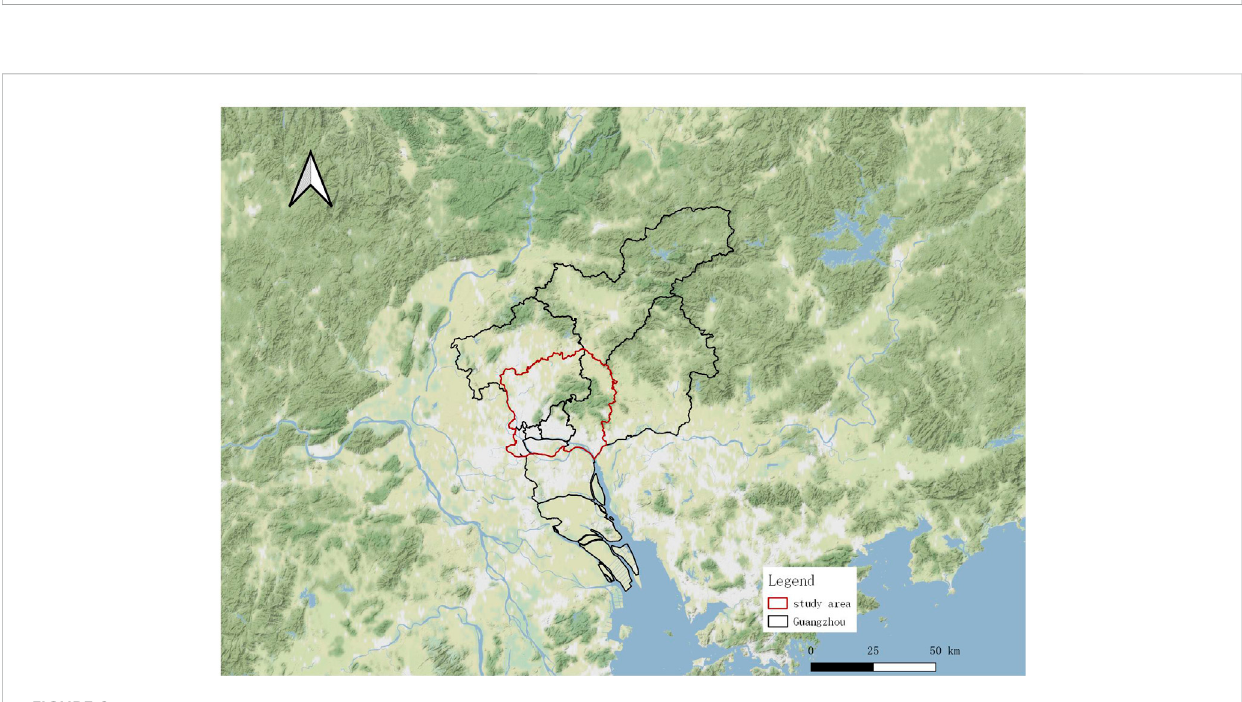
FIGURE 2 Study area (Source: Drawn by the